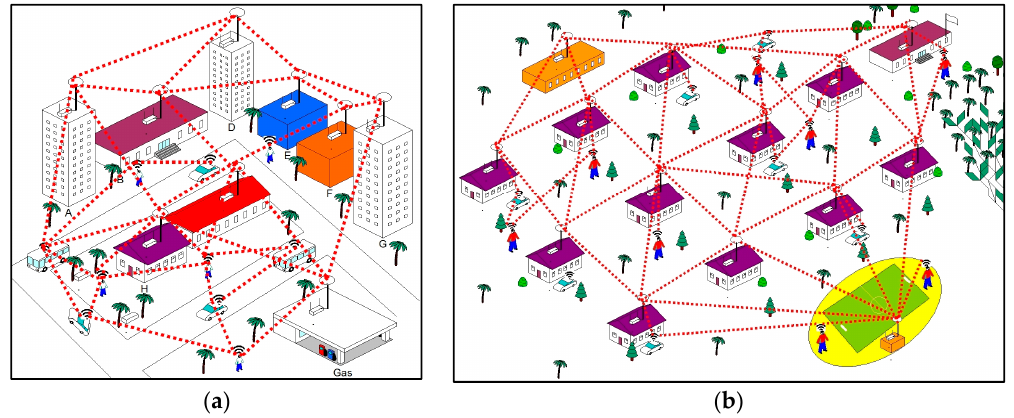
Figure 3. Examples of urban and rural mesh network deployments: ( a ) urban mesh network where homes, public buildings, and private offices could be serviced by WMNs and the network can adapt based on nodes addition and removal; ( b ) a rural area where homes, police, hospitals, and schools could be connected with WMNs.